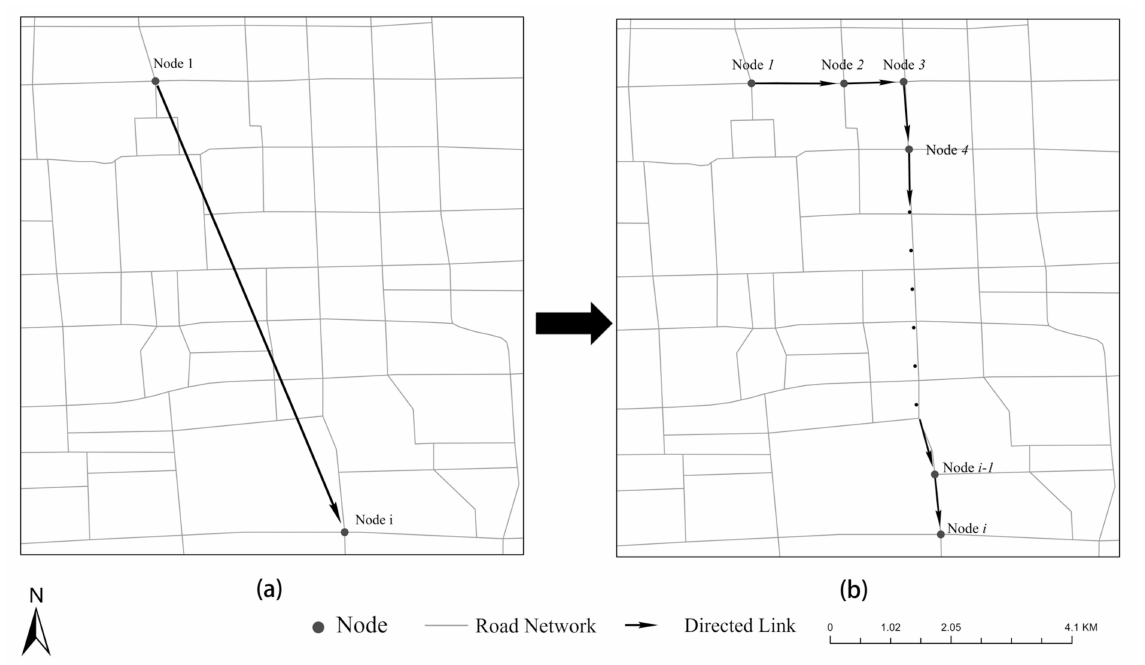
Figure 2. A sequential pair of geotagged microblogs ( a ) and the trajectory ( b ) of tourist p